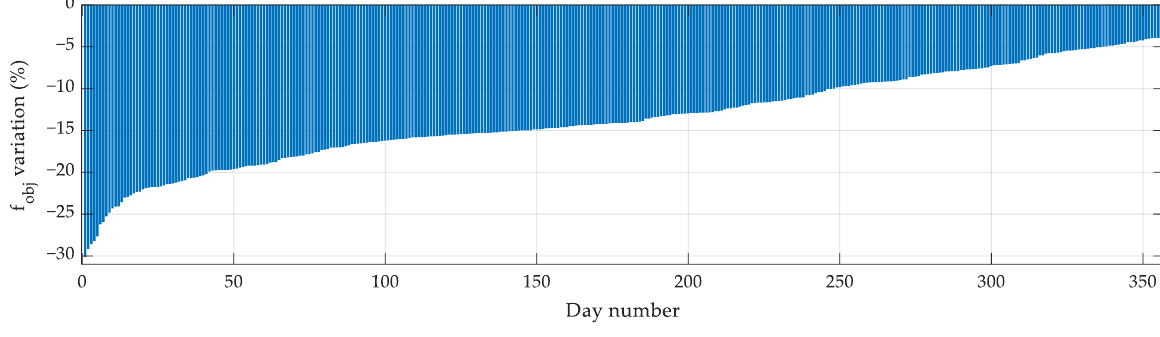
Figure 3. Performance comparison between the ISCA and SCA during each day of the year.